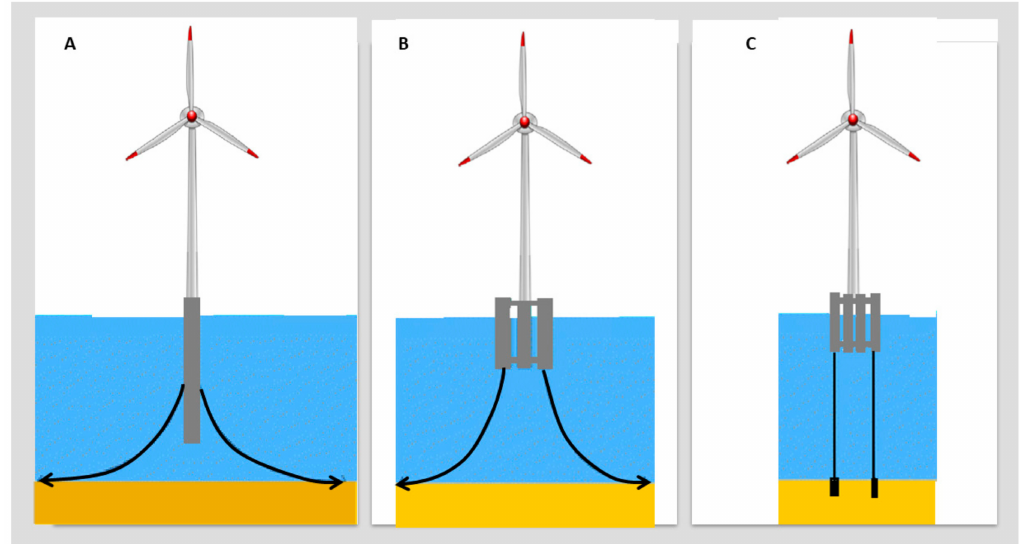
Figure 11. Floating wind foundations typologies [76]. ( A ) Spar-buoy structure. ( B ) Semisubmersible. ( C ) Tension leg platform